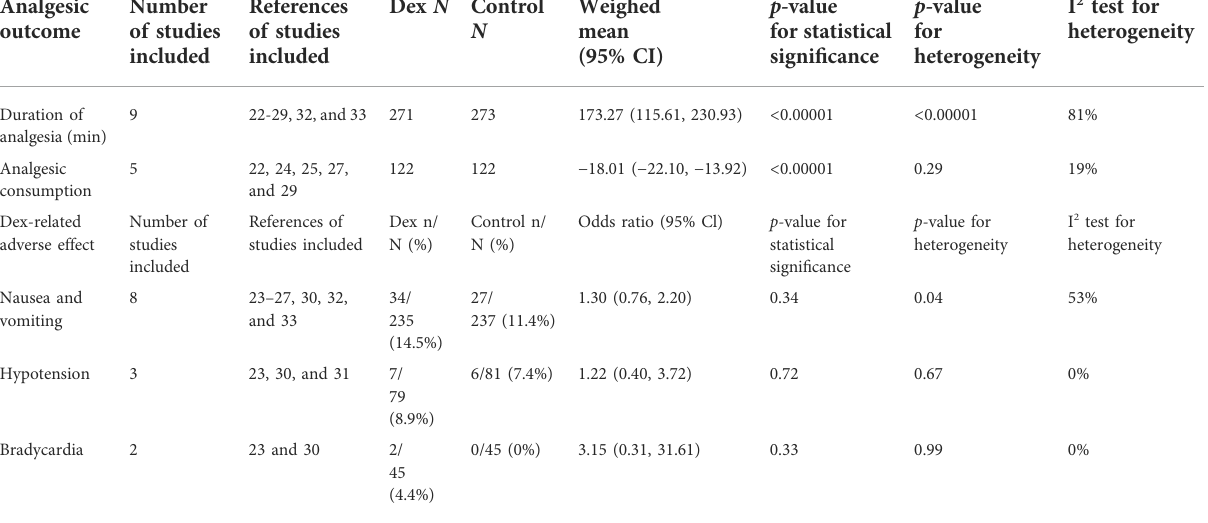
TABLE 3 Summary of secondary